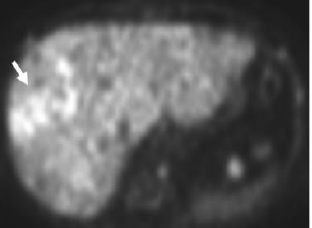
Figure 21. Same patient as Figure 10. Axumin PET image shows physiologic uptake within the liver with more intense uptake in the right hepatic lobe, suggesting metastatic disease. The heterogeneous physiologic uptake pattern in the liver may make identifying small hepatic metastases challenging.